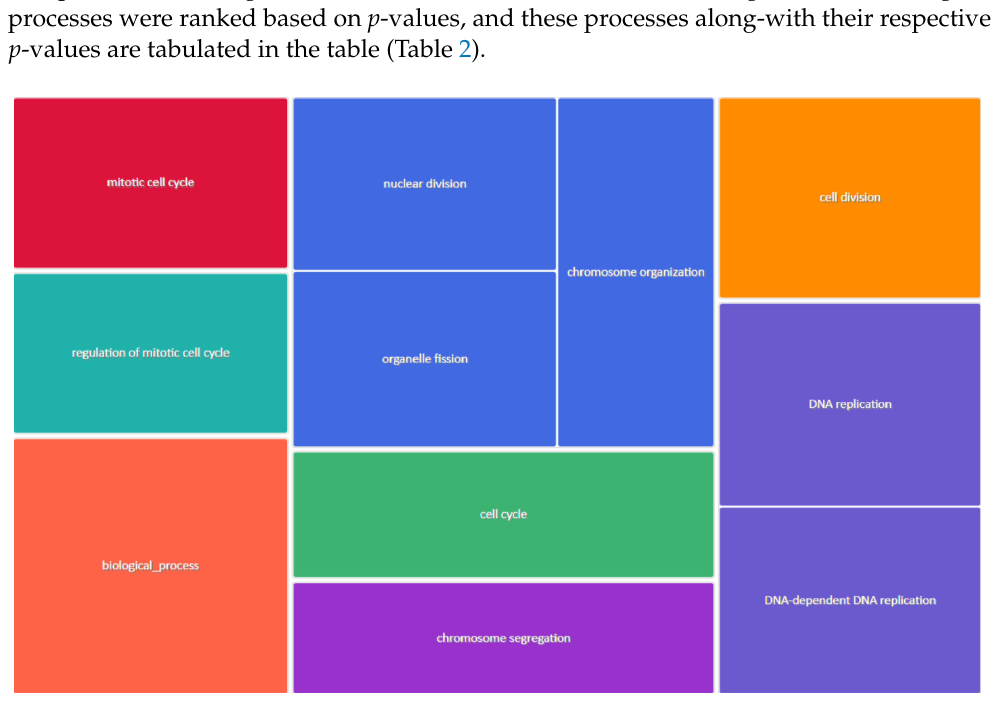
Figure 5. Tree map showing the Biological Processes (BP) based on p -values drawn from Revigo in which the hub genes were significantly enriched. The plot represents highly similar GO terms based on their respective p -values. Each rectangle in the tree map represents a single cluster representative. The different clusters are represented by different colors. The size of the rectangles is based on either the p -value or frequency of the GO terms in the GOA database. Table 2. Top 10 significantly enriched biological processes along with their respective p -values.